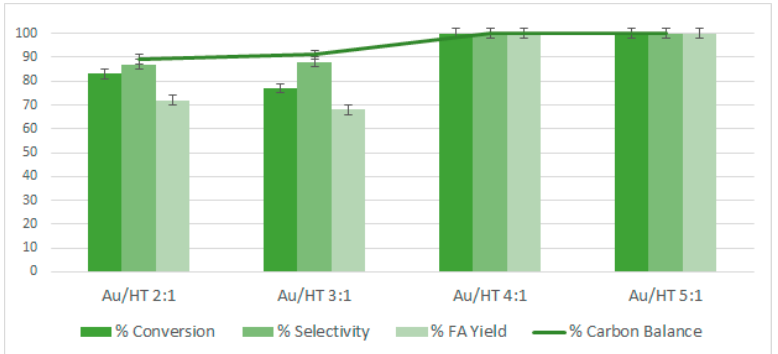
Figure 6. Comparison of the performance in furfural oxidation of Au/HT catalysts with supports having different molar Mg: Al ratios. Batch reactor, p = 6 bar (O 2 ), t = 110 °C, 2 h, 600 rpm, FF/Au molar ratio = 200:1, [FF] = 26 mM, 25 mg of catalyst.